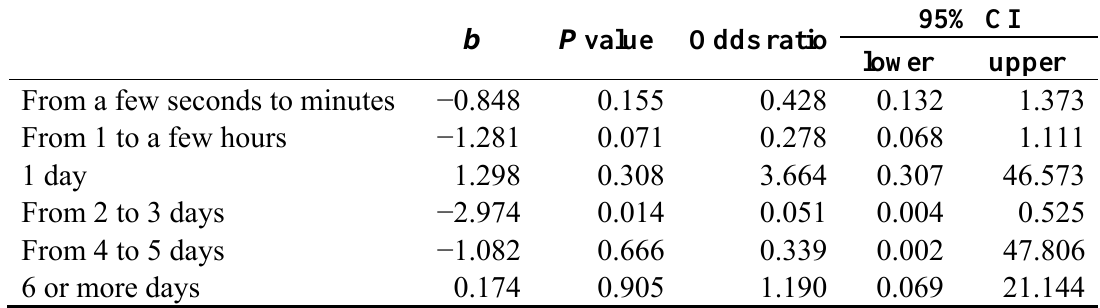
Table 4. Results of regression model to evaluate relationships between the epicentral distance and the presence of unusual behaviors of cats during each time period; CI = confidence interval b =